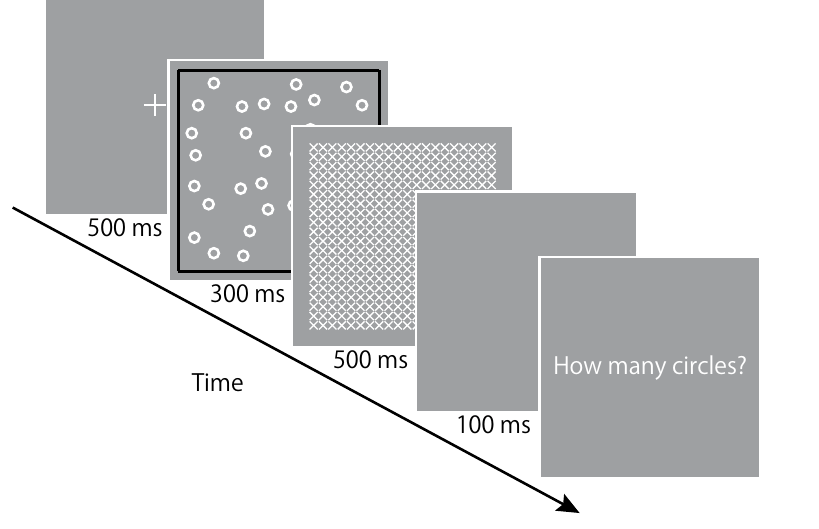
Figure 3. The sequence of trial events in Experiment